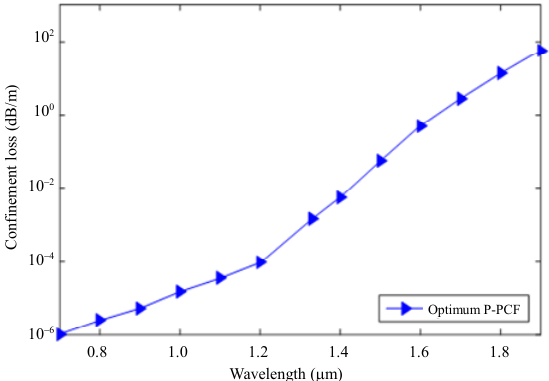
Fig. 6 Variation of confinement loss verses applied wavelength for the optimum structure.